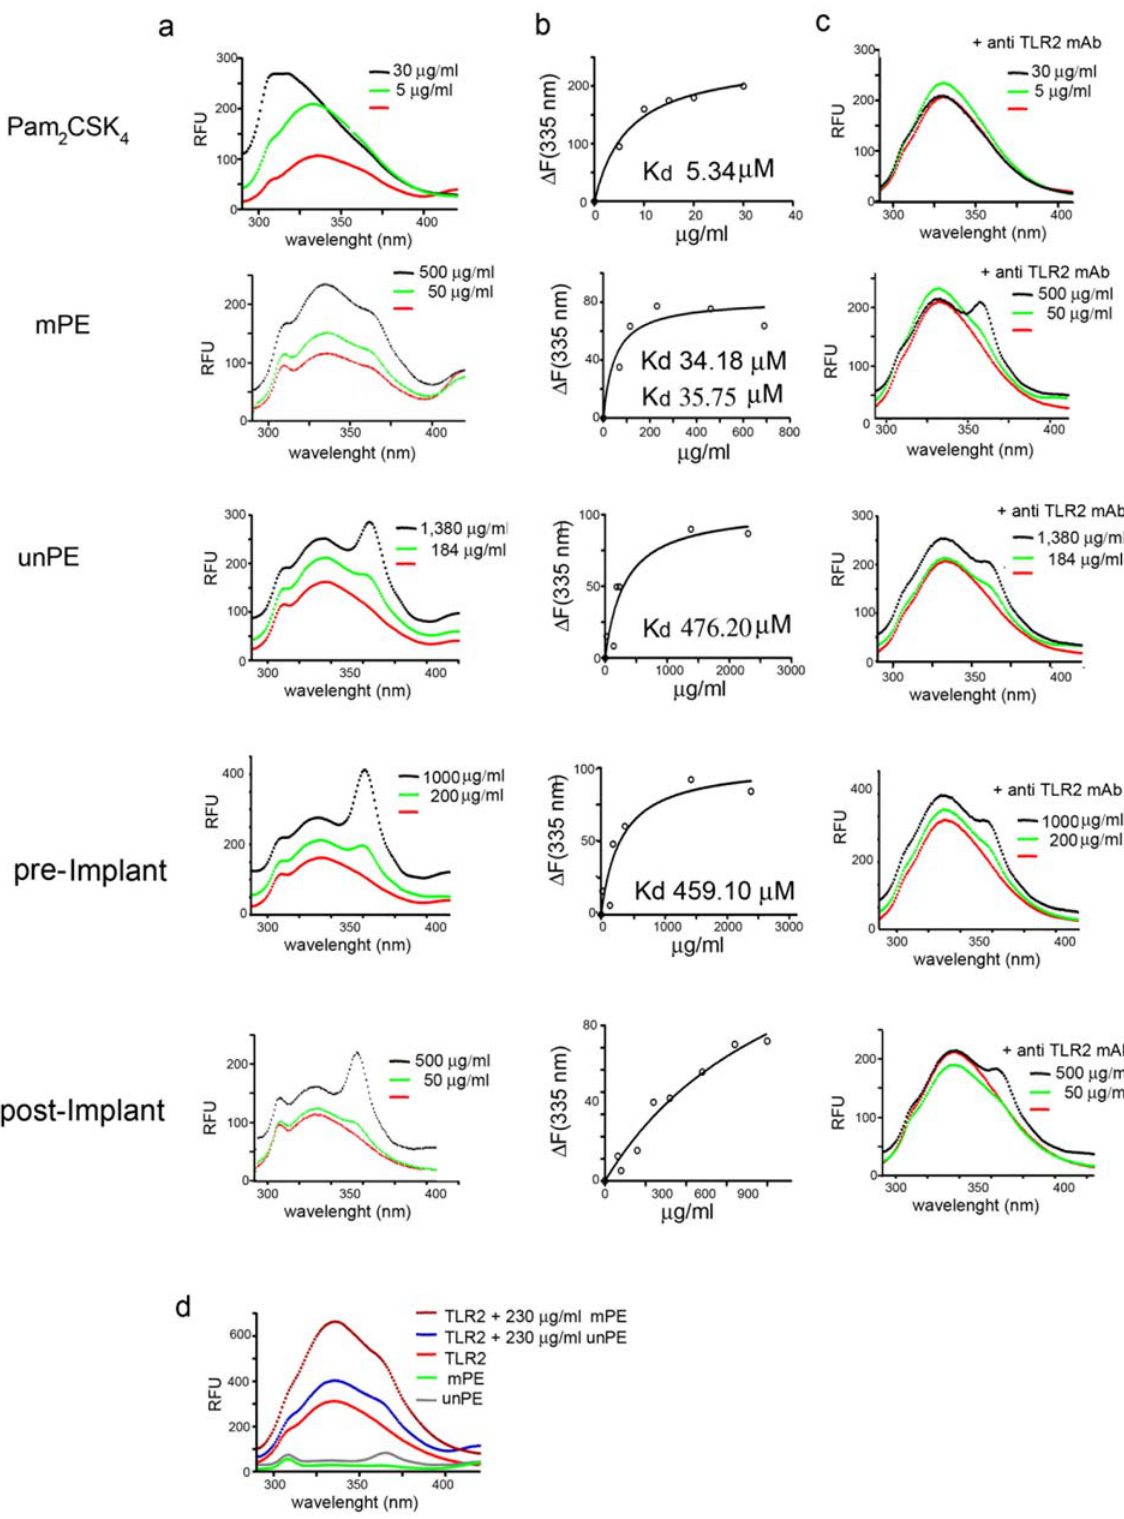
Figure 6. Direct binding of oxidized alkane polymers to soluble TLR-2 molecules. a) Left panels; fluorescence emission scans collected for free soluble TLR2 and TLR2 in complex with two different concentrations (exponential and plateau) of each analyzed polymer. Central panels; normalized fluorescence data ( D F) for each concentration point as a function of the free ligand concentration. Right panels; fluorescence emission scans collected for free soluble TLR2 and TLR2 in complex with each analyzed polymer at two different concentrations (exponential and plateau) in presence of an anti TLR2 mAb known to block the TLR2 binding groove (stoichiometric ratio 2:1 Ab to soluble TLR2 receptor). b) Comparison of the fluorescence emission scans collected for soluble TLR2, mPE and unPE.